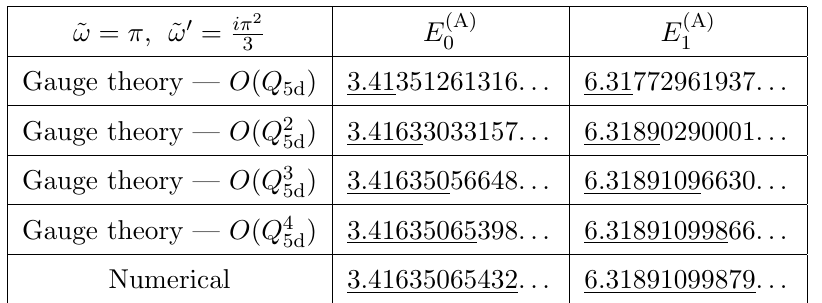
p p 7, ~ y = 2, obtained from